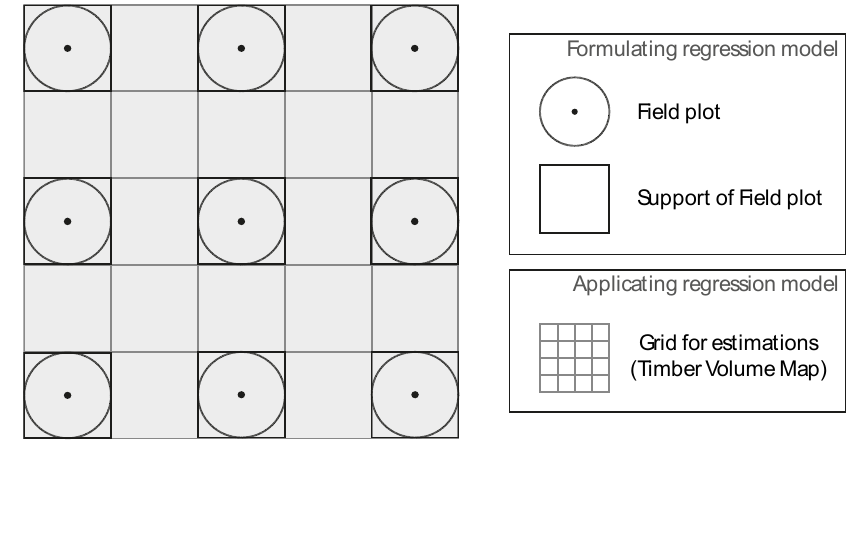
Figure 4. Schematic design of the timber volume